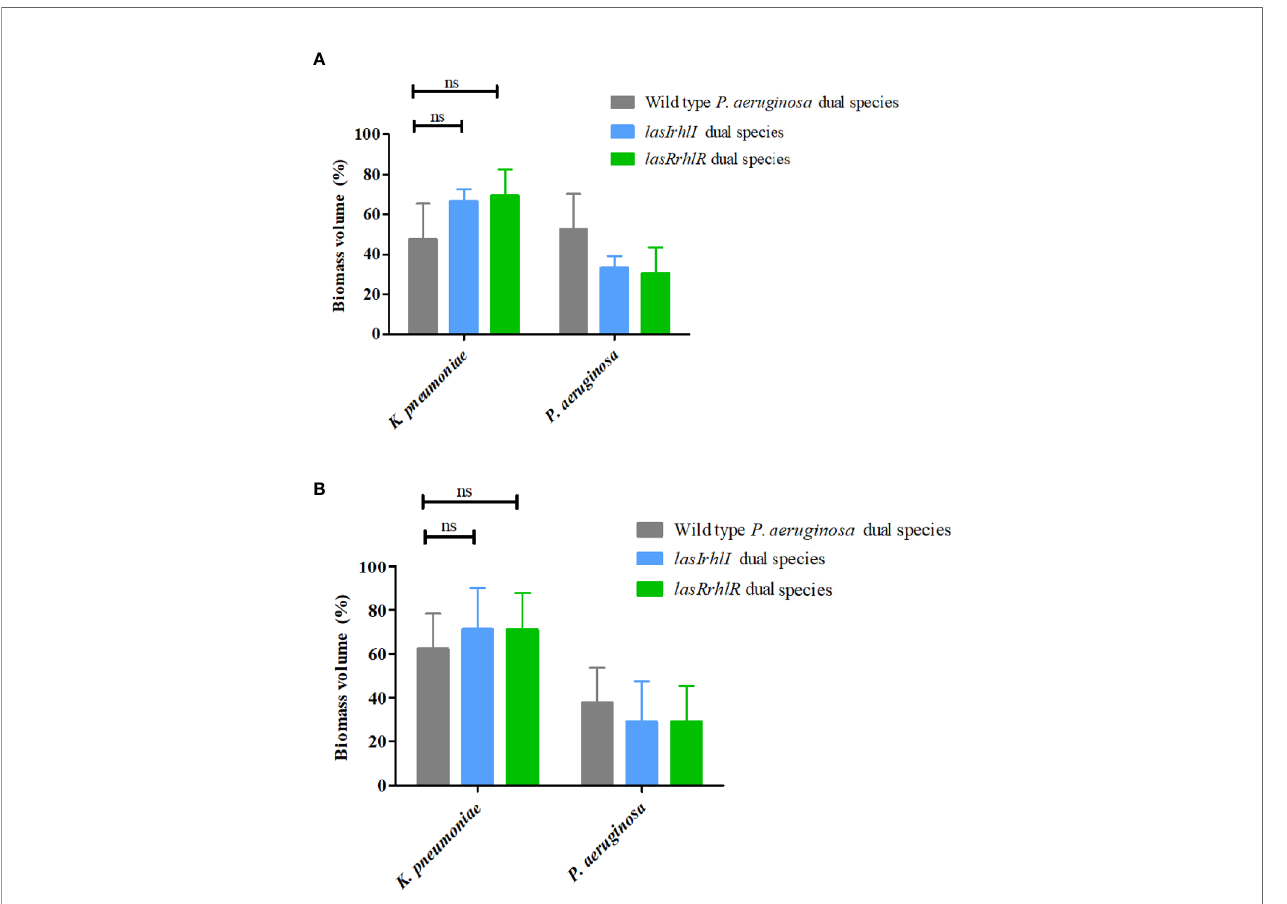
FIGURE 2 | Proportions of K. pneumoniae - P. aeruginosa dual-species bio fi lm. The proportions of the two species in the dual species bio fi lm containing either the P. aeruginosa wild type or the QS mutants ( lasIrhlI or lasrRrhlR ) after (A) 3 days and (B) 5 days of cultivation. Bar charts depict the percentages of K. pneumoniae and P. aeruginosa in the wild type or QS mutant containing dual species bio fi lms. The proportions were derived by cultivating bio fi lms under fl ow cell conditions followed by quantitative image analysis of two independent biological replicates. Error bars represent standard deviations (n = 2). ns denotes there were no signi fi cant